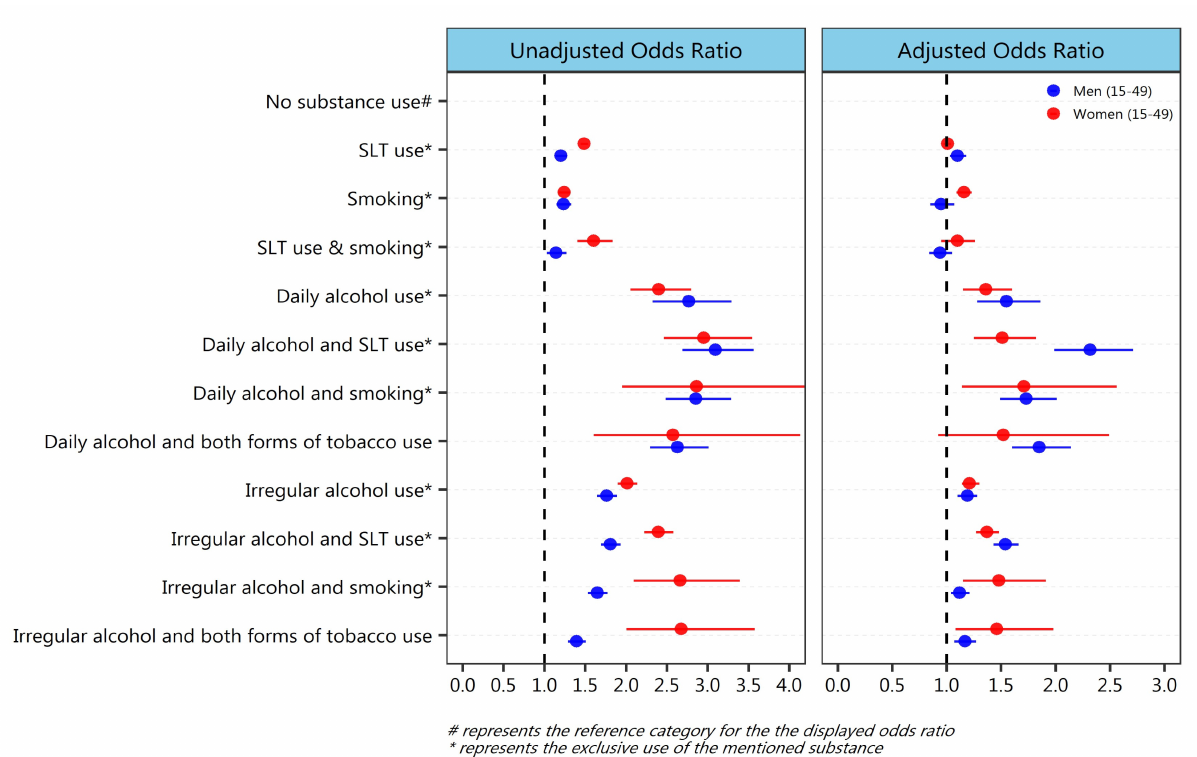
Figure 2. Unadjusted and adjusted effect (odds ratio) of mutually exclusive and mixed consumption patterns of alcohol and tobacco among men and women aged 15–49 on their hypertensive status, India,